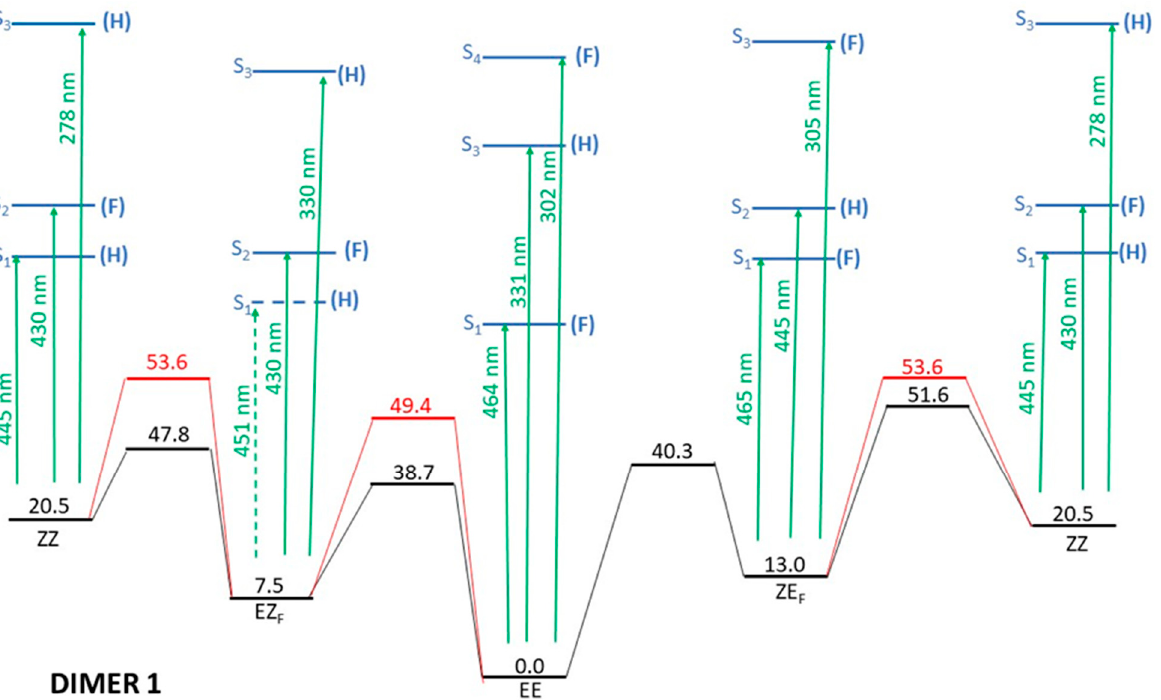
Figure 3. Full energy scheme of the ground and lowest excited electronic states of dimer 1. See text for details. Relative energies of the different structures (horizontal lines) are given in kcal/mol. Green arrows indicate the wavelengths of the vertical excitations from each conformer. Black lines indicate the ground electronic state whereas excited electronic states are in blue. Red lines correspond to crossing sections between S 0 and S 1 .